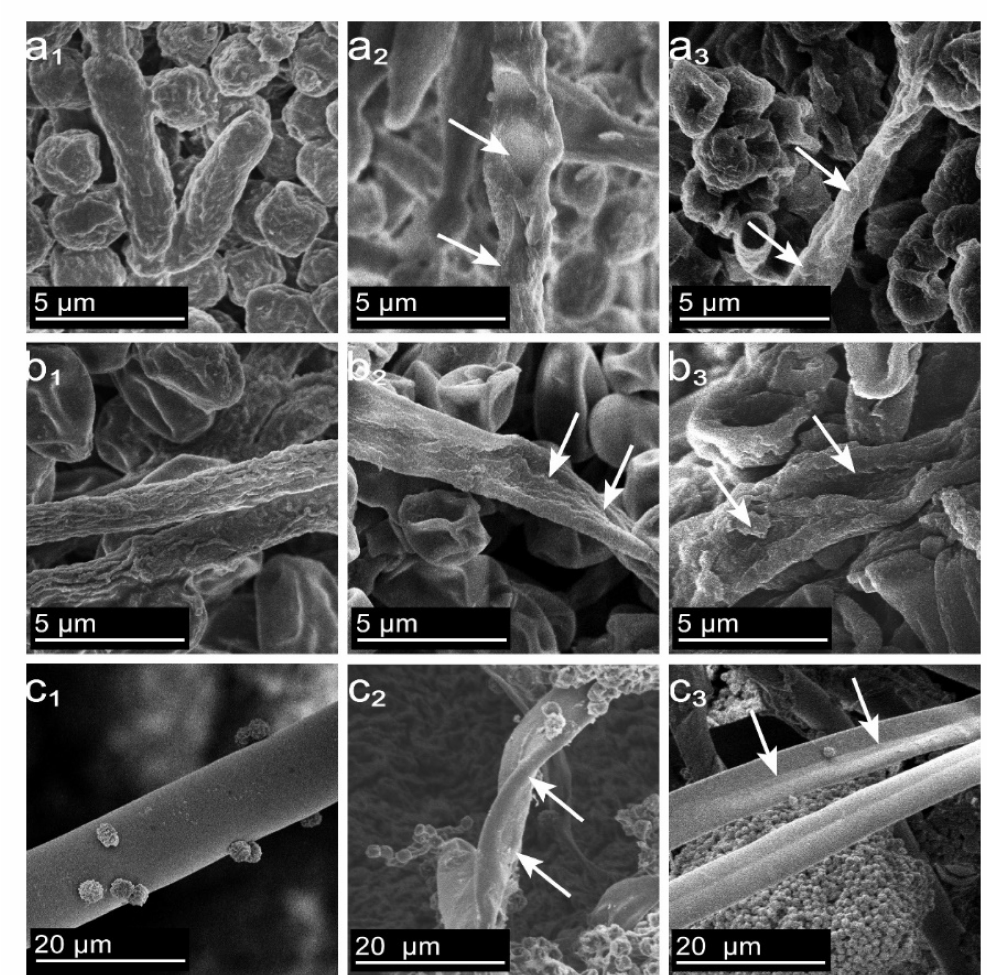
Figure 5. Effect of dodecylpyridinium chloride treatment on the surface morphology of mycelium of bamboo material (( a – c ) PC, TV, and AN, respectively; subscripts ( 1 – 3 ) are control, MIC, and MFC,